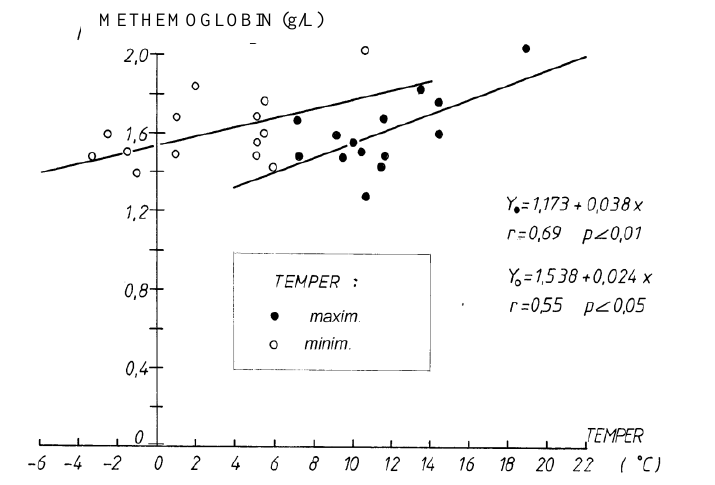
Figure 2. Correlation between the level of methemoglobin and the daily maximum and minimum air temperatures during the exposure period (December 20, 1989 to March 20,